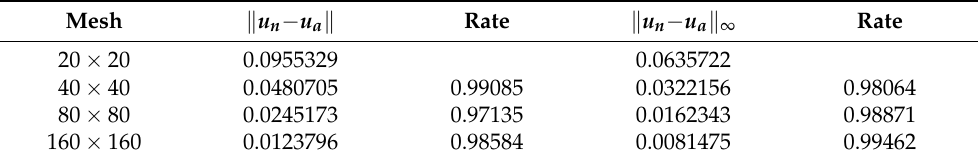
Table 1. The L2 norm, infinite norm of the error, and convergence order (rate) values. Mesh